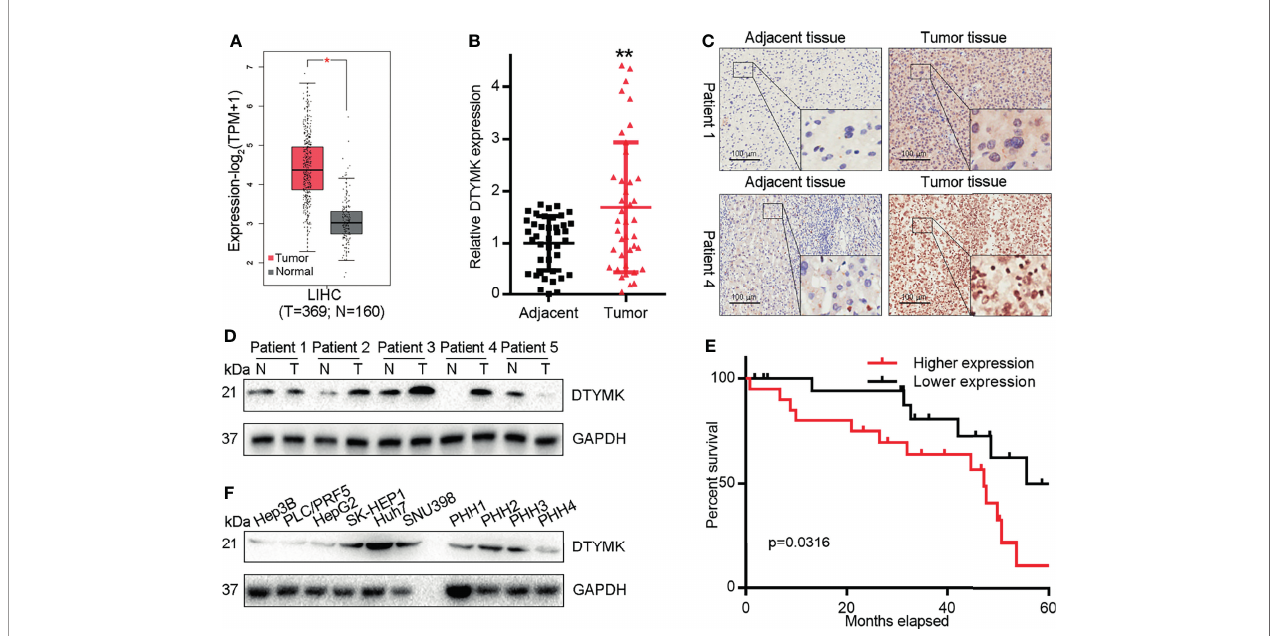
FIGURE 1 | HCC is associated with DTYMK upregulation. (A) DTYMK levels in human HCC tumor and non-tumor tissues in the GEPIA database. (B) DTYMK expression was assessed via qRT-PCR in clinical HCC tumor and paracancerous tissues (n = 40). (C) DTYMK protein levels were assessed via IHC in HCC tumor and paracancerous tissues. Scale bar, 100 m m. (D) DTYMK protein levels were assessed via IHC in HCC tumor and paracancerous tissues via Western blotting. (E) The relationship between DTYMK mRNA levels and survival were assessed in 40 HCC patients via Kaplan – Meier analyses. (F) DTYMK protein levels were assessed via Western blotting in Hep3B, PLC/PRF5, HepG2, SK-HEP1, Huh7, and SNU398 cells and primary human hepatocytes (PHH-1, 2, 3 and 4). Data are means ± SD. *p < 0.05; ** p < 0.01; Student ’ s t-tests and Kaplan-Meier